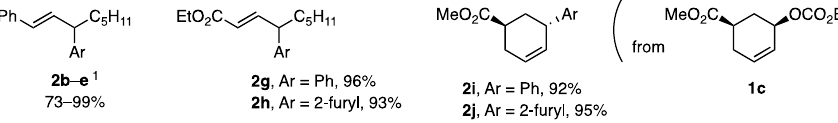
Figure 1. Products 2b – j from borates with ligand A . 1 b , c , d : 2-, 3-, and 4-MeOC 6 H 4 ; e and 2-fury.